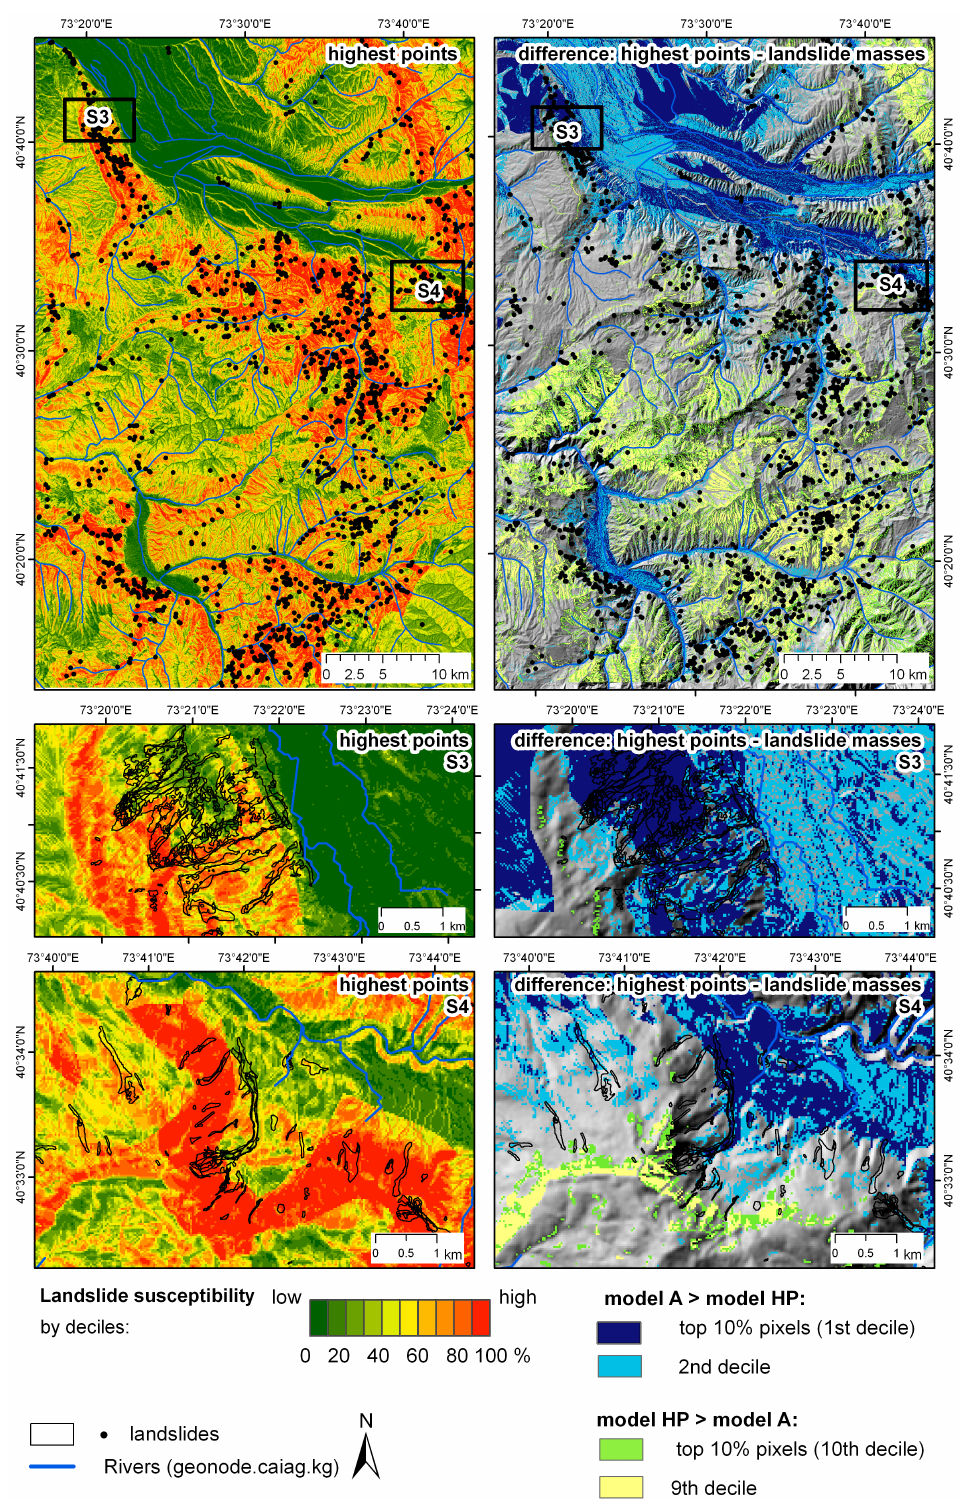
Figure 6. Results of susceptibility assessment produced using landslide masses (model A) and landslide highest points (model HP) of automatically detected landslides (1986–2016): study area and two